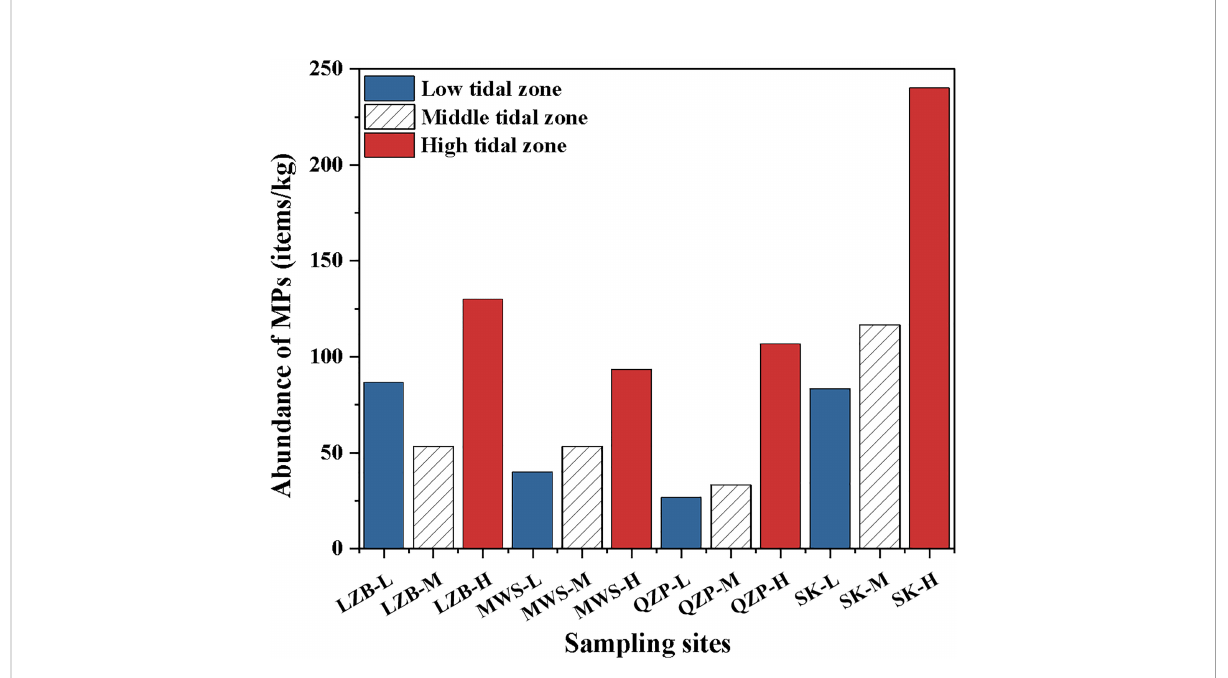
FIGURE 2 Variation in microplastic (MP) abundance in the studied mangrove